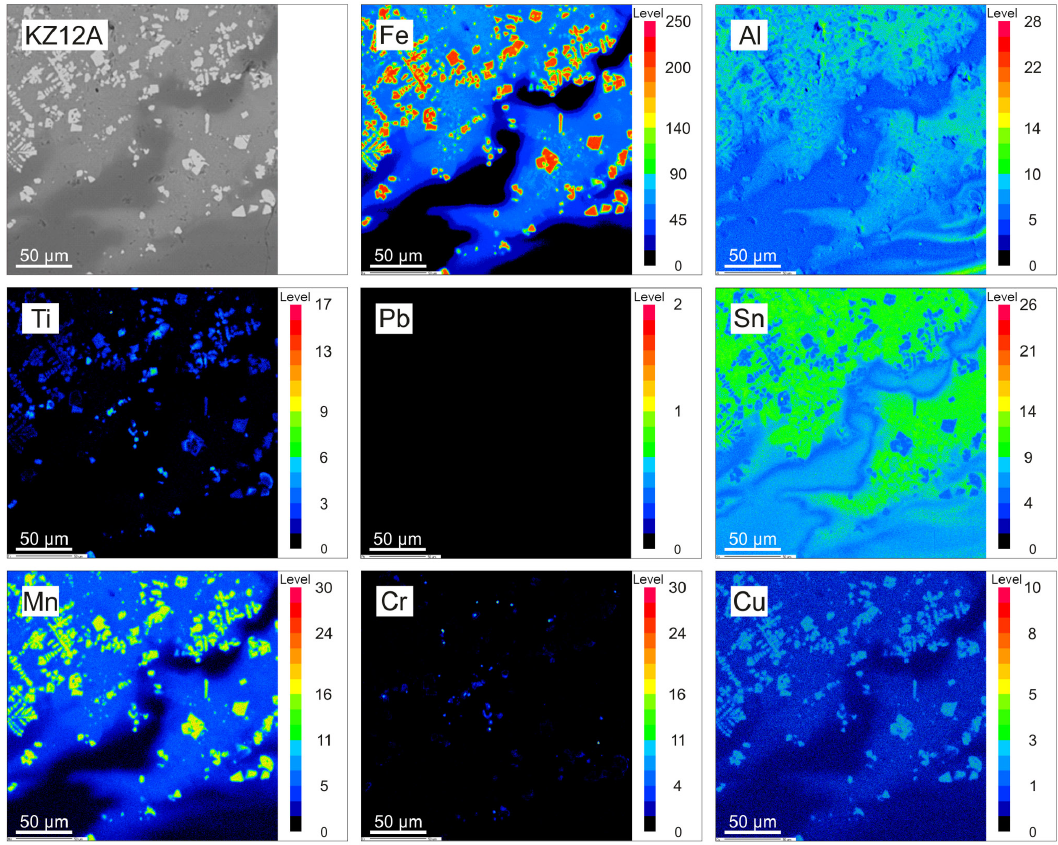
Figure 1. MSWI BA WDX maps. Glassy matrix of the BA grain rich in metallic inclusions (mostly Fe-Mn-rich